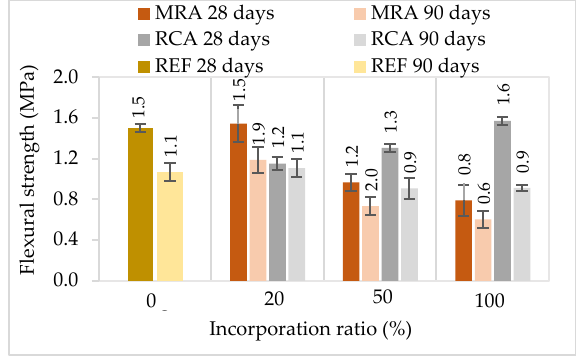
Figure 5. Flexural strength of the mortars tested at 28 and 90 days.